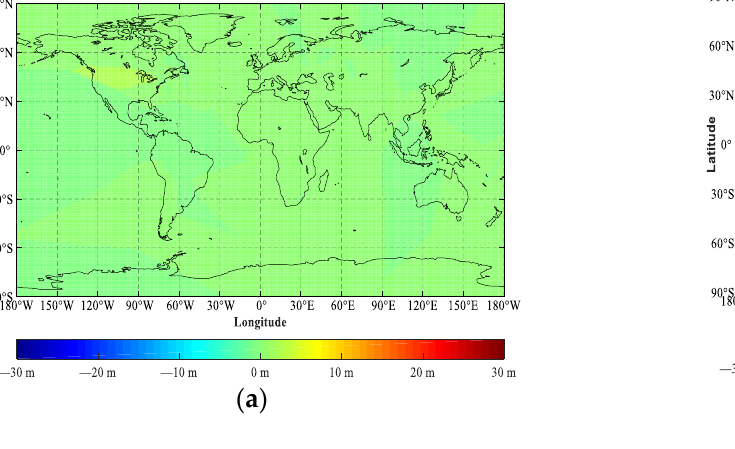
Figure 2. Global test statistics distribution of CODM based on (a) GPS and (b) BDS observation under case1 and case2.